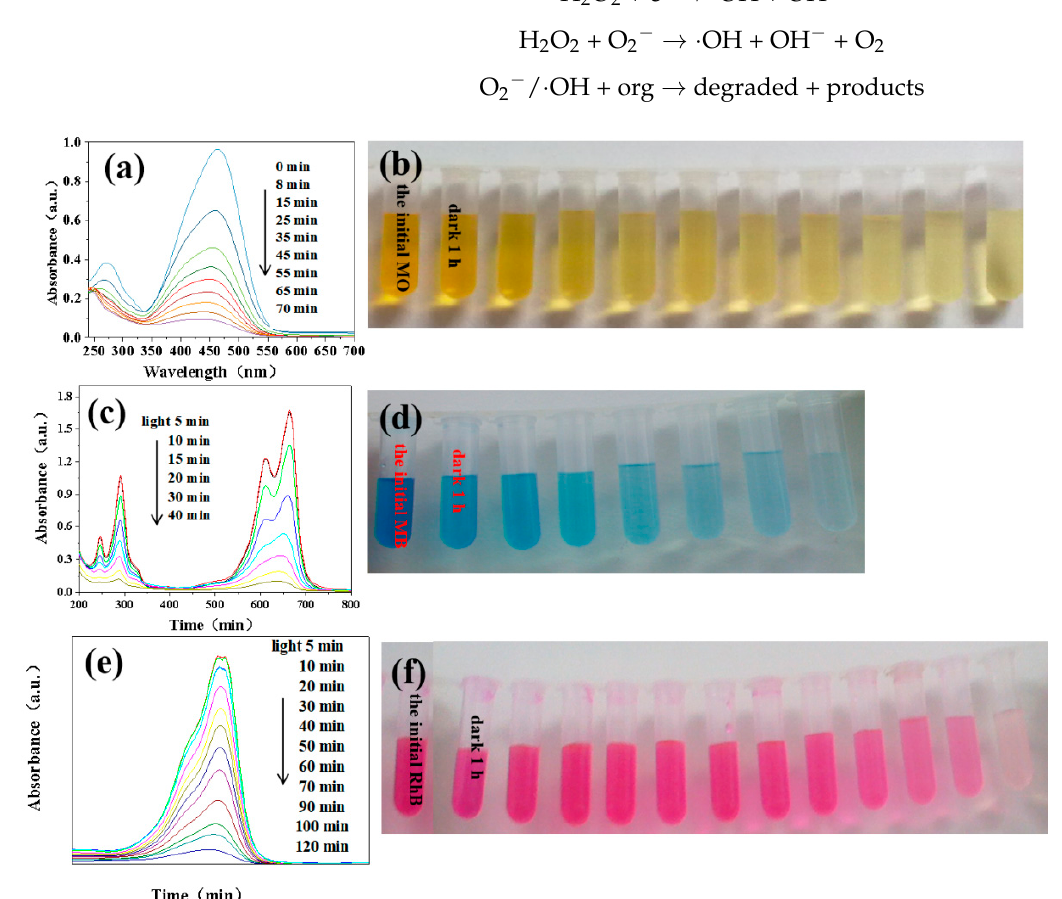
Figure 5. Photocatalytic degradation curves of different dyes: ( a ) MO; ( c ) MB; ( e ) RhB. Images of the dyes at different degradation times: ( b ) MO; ( d ) MB; ( f ) RhB.